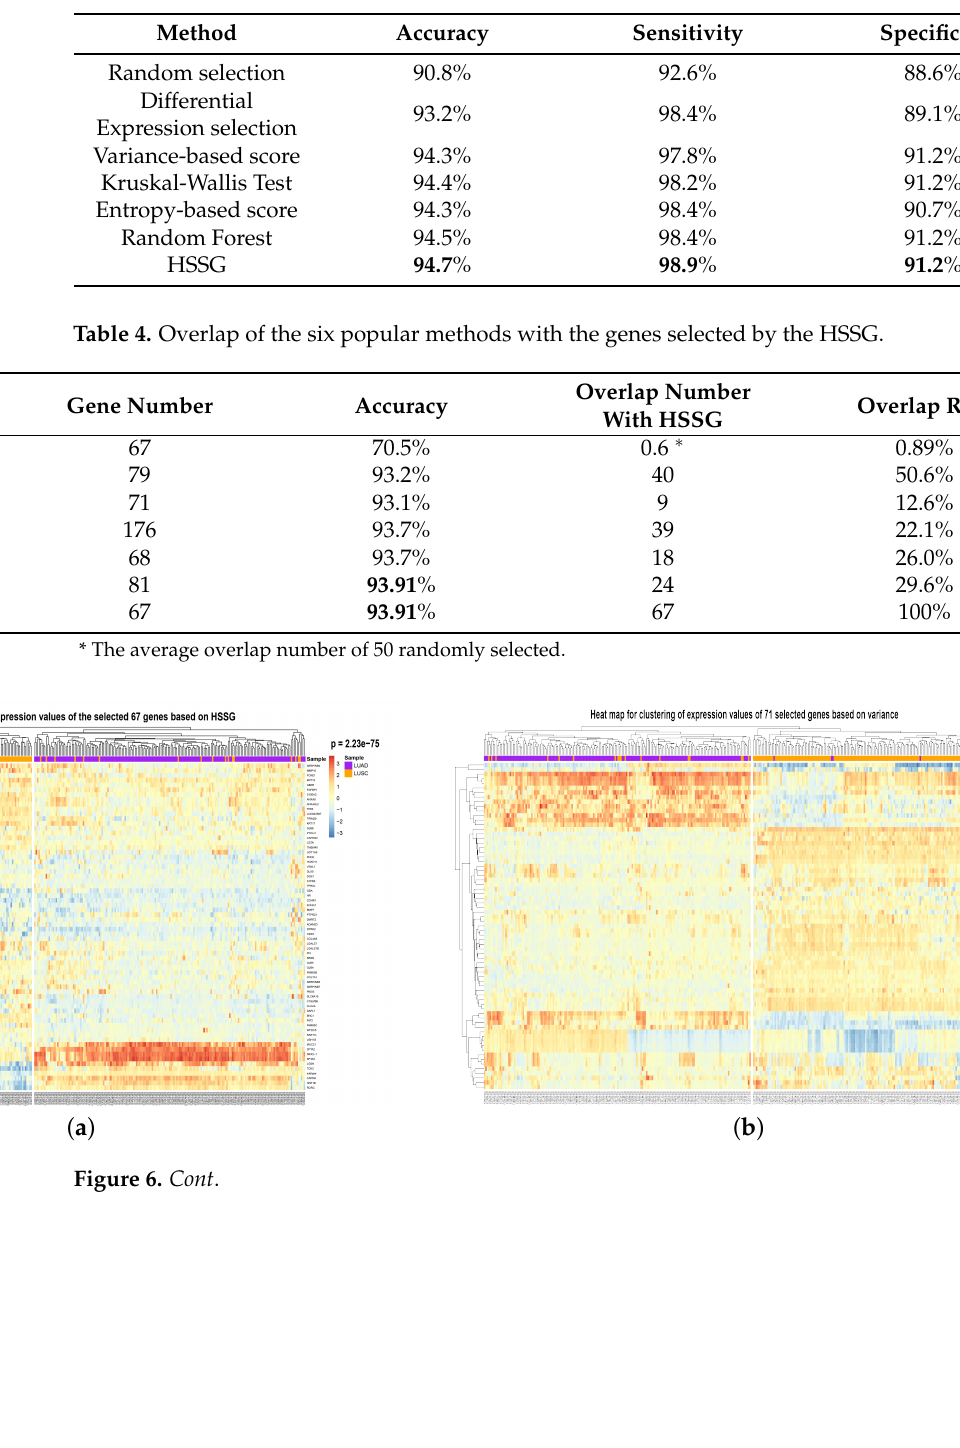
Table 3. Comparison with six popular feature scoring methods in selecting 644 genes.